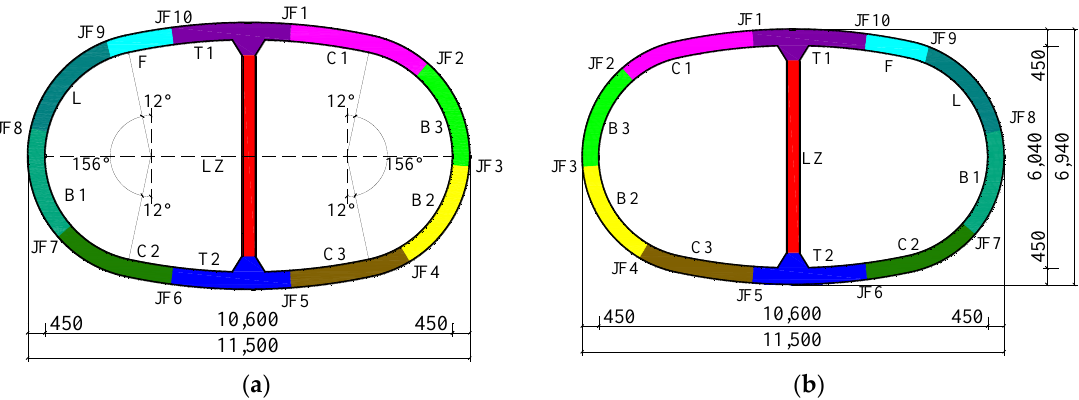
Figure 2. Outline of a typical lining structure of the Ningbo quasi-rectangular tunnel (unit: mm): ( a ) pattern A; ( b ) pattern B.